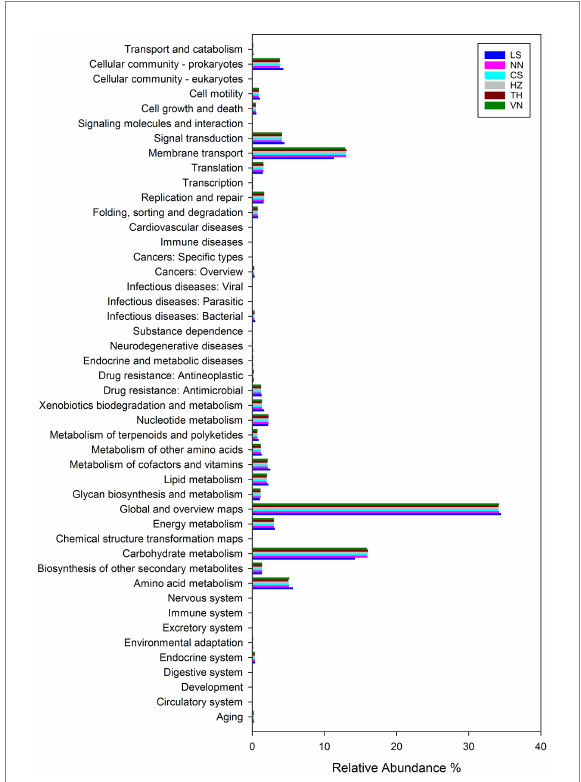
FIGURE 7 Comparison of predicted GO functions of the gut bacteria in C. medinalis from different geographic